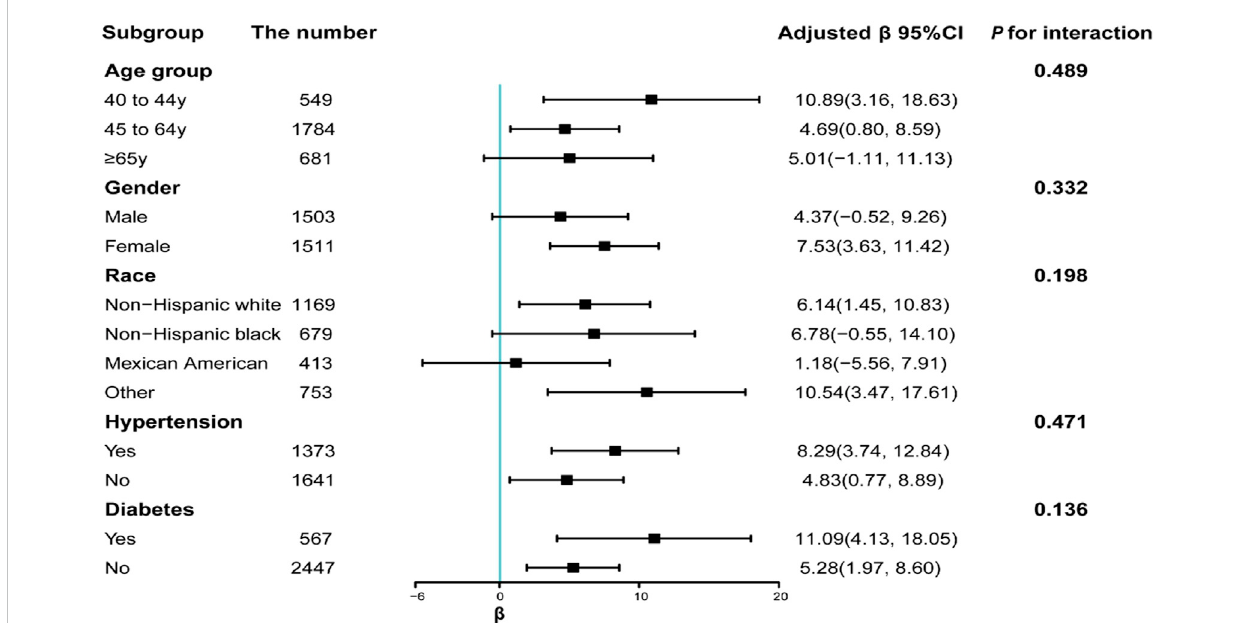
FIGURE 2 Subgroup analyses of the association between serum manganese and serum klotho levels. Each strati fi cation was adjusted for all factors (i.e., age, gender, race, educational attainment, marital status, PIR, smoking habit, alcohol use, physical activity, BMI, 24-h total energy intake, diabetes, and hypertension), except for the strati fi cation factor